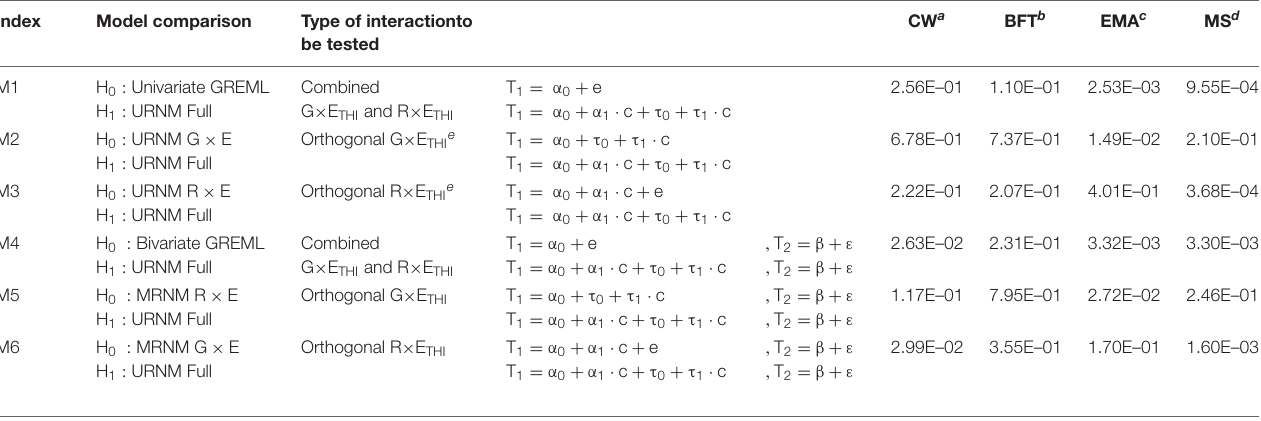
TABLE 1 | P -values of likelihood ratio tests for model comparisons in carcass traits analyses using